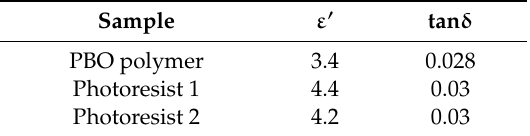
Table 2. The dielectric parameters of film coatings of the PBO polymer and photoresists based on it, measured at 1 MHz at room temperature.